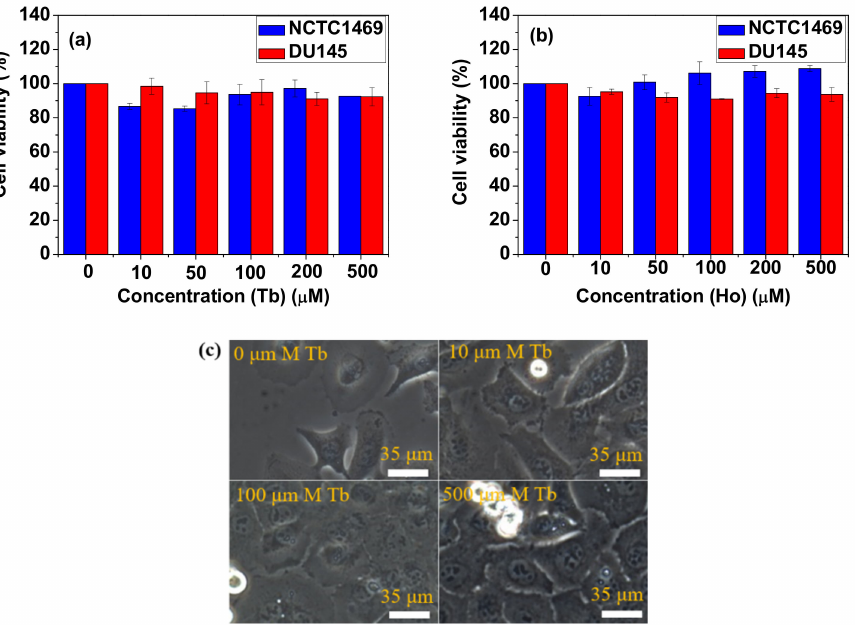
Figure 5. In vitro cell viabilities of NCTC1469 and DU145 cells incubated with the PAA-coated Ln 2 O 3 NPs [Ln = ( a ) Tb and ( b ) Ho]. ( c ) Optical images of DU145 cancer cells incubated with PAA-coated Tb 2 O 3 NPs at various